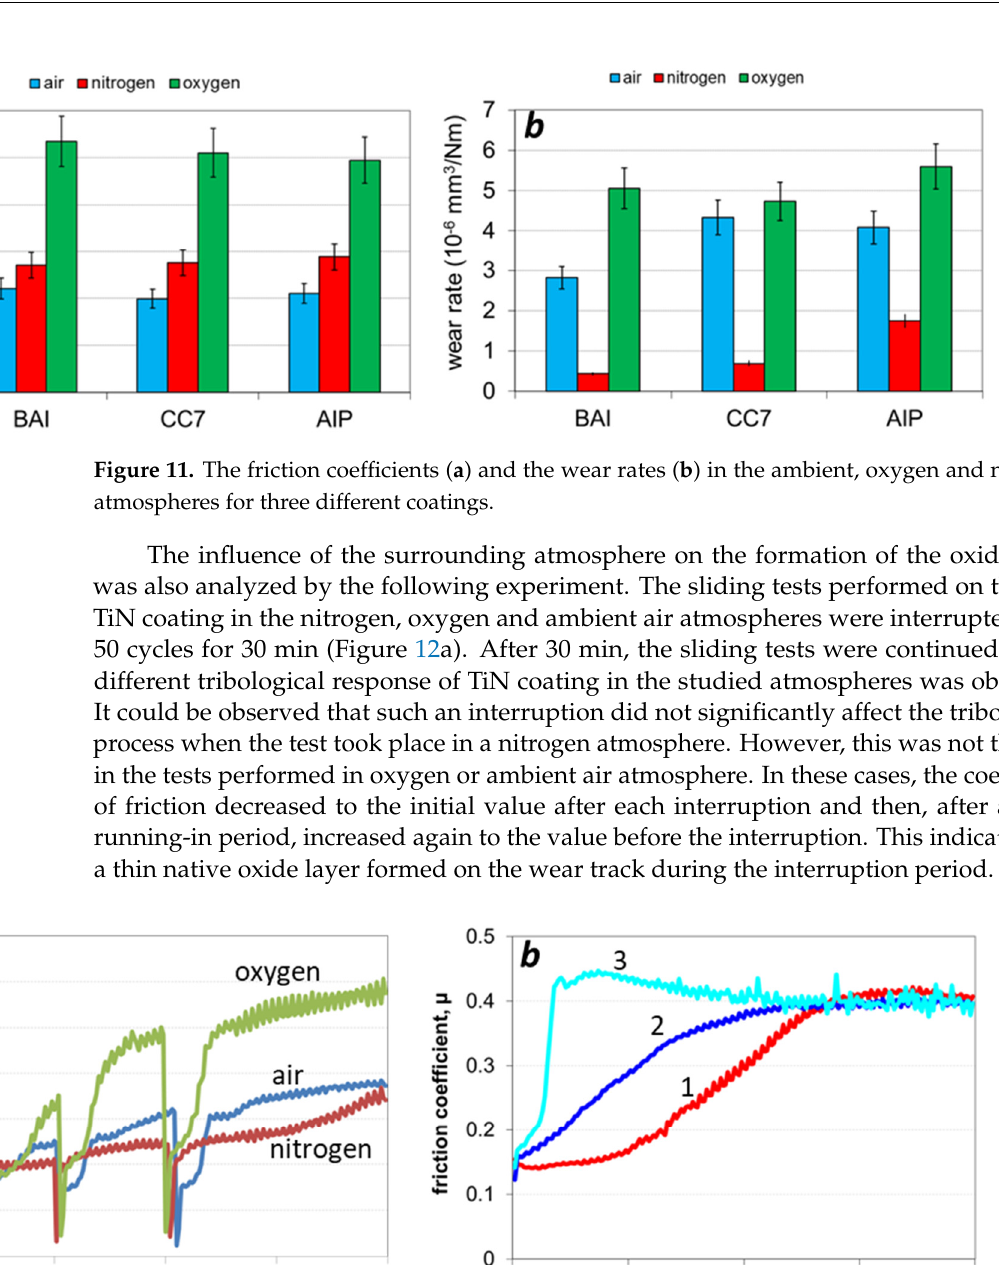
Figure 10. Series of 250 line profiles stacked together from the recorded profiles. The wear track of BAI TiN coating is shown for different surrounding atmospheres (( a )—nitrogen, ( b )—air, ( c )—oxygen). The scanning area was 0.5 mm × 0.5 mm. The blue profile represents the level of coating, while grey peaks represent protrusions. During the sliding test (1000 cycles), the protru- sions were removed and the wear tracks with various depths were formed. Note the strong exag- geration in z-scale. “A” is the cross-section area of the wear track.